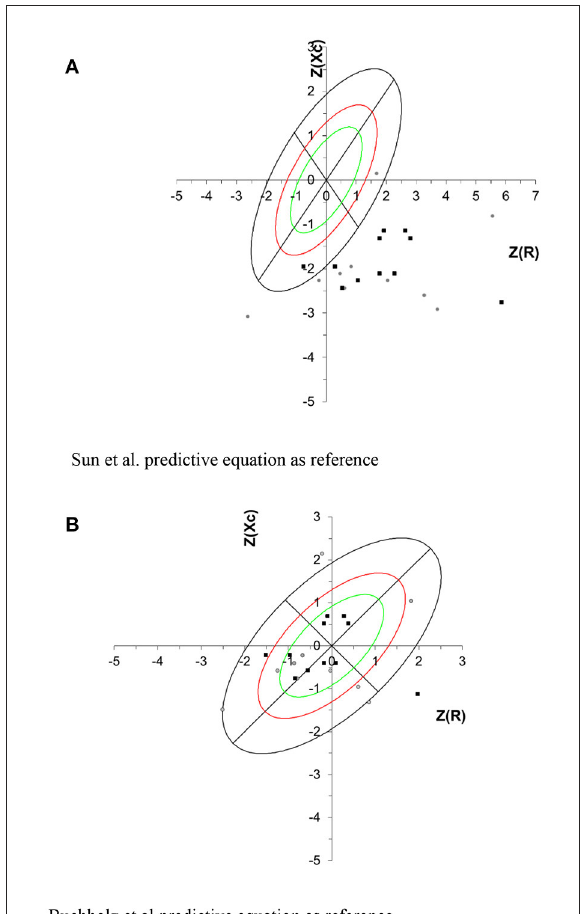
FIGURE2 Tolerance intervals for the impedance vector are described as tolerance ellipses of 50% (green), 75% (red) and 95% (black) calculated from the healthy reference population. Gray circle represents the NPA group, and black square represents the PA group. For all participants the correlation between R/H and Xc/H was 0.363. (A) Sun et al. predictive equation as reference. (B) Buchholz et al. predictive equation as